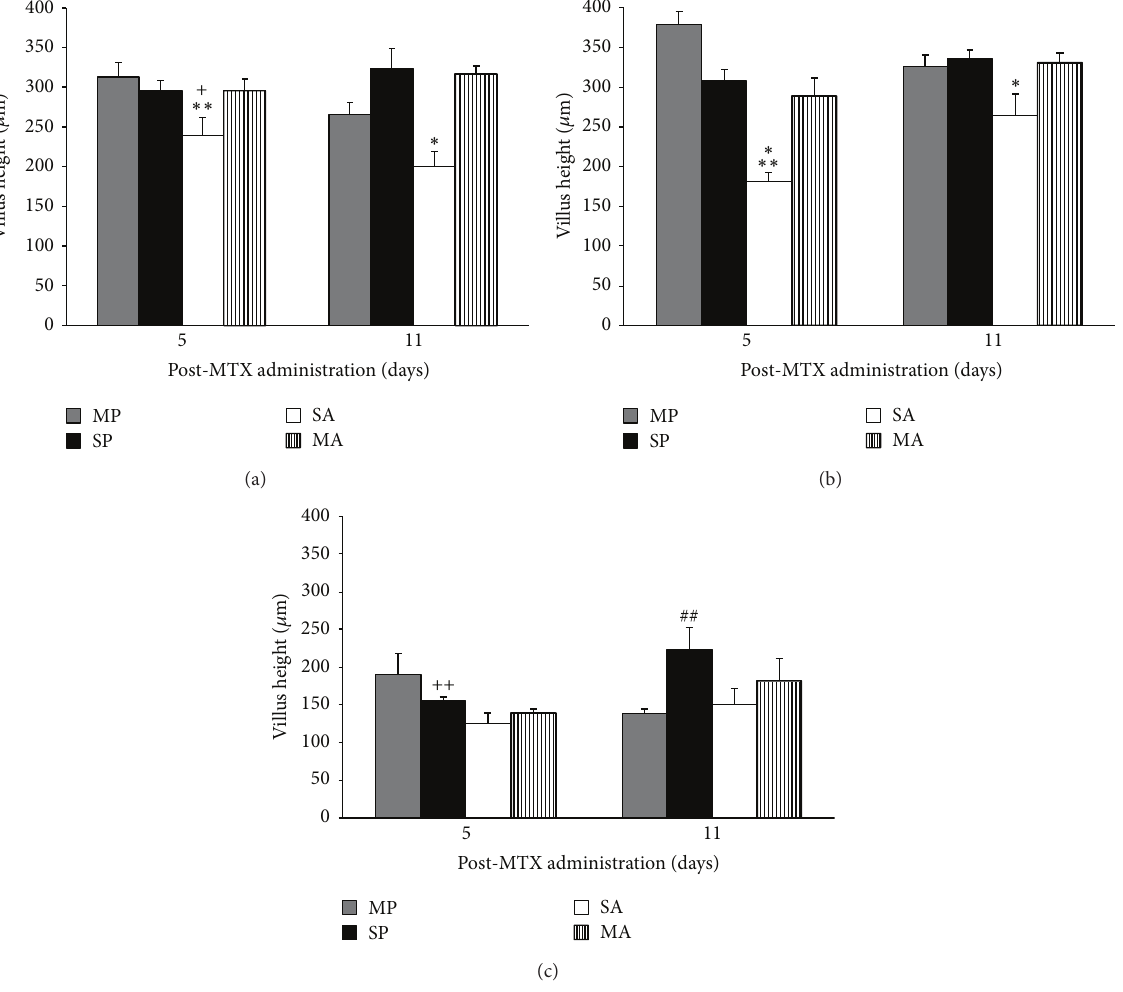
Figure 4: Villus height ( 𝜇 m) in the duodenum (a), jejunum (b), and ileum (c) of C57BL/6 mice treated with PS, PM, AS, and MA. ∗ denotes significant difference ( 𝑃 < 0.05 ) compared to all other groups. ∗∗ denotes significant difference ( 𝑃 = 0.027 ) compared to day 11. + indicates significance ( 𝑃 < 0.01 ) compared to PS on d 5. ## indicates significant difference compared to PS and PM groups on d 11. ++ indicates significant difference ( 𝑃 = 0.015 ) compared to d